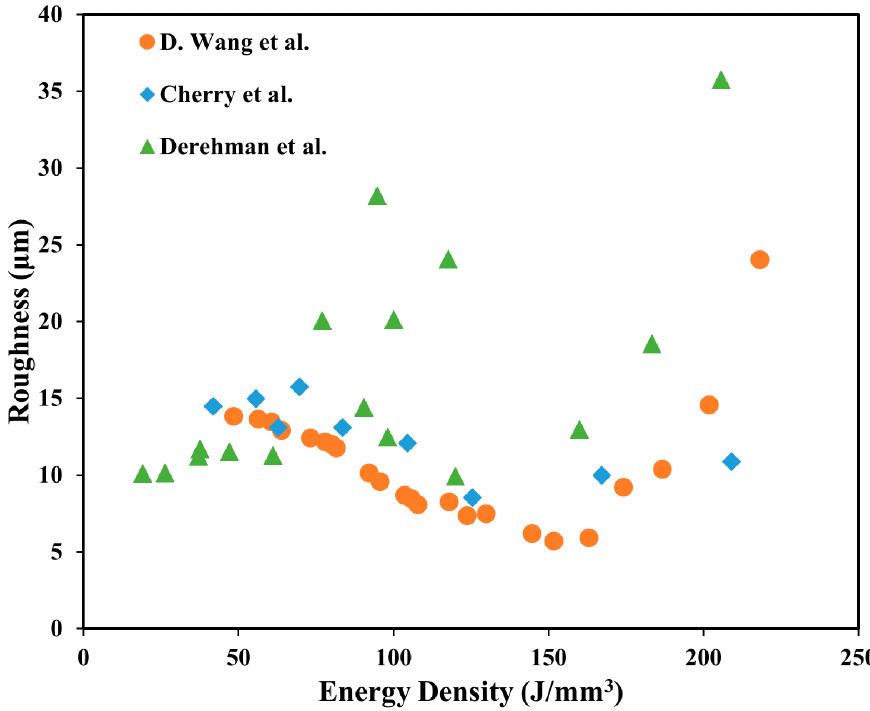
Figure 2. The relationship between energy density and average roughness ( R a ) for P-LBF 316L steel.